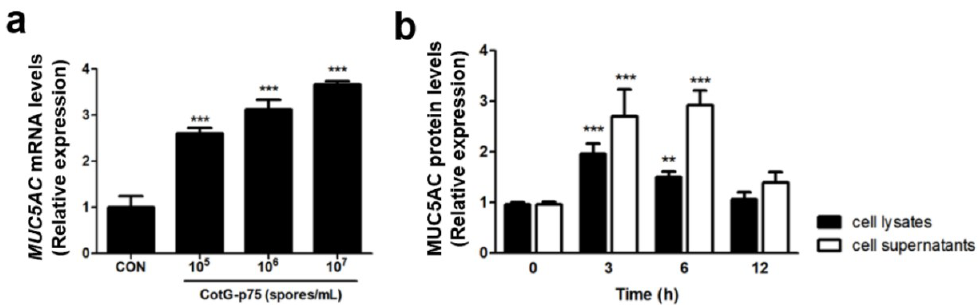
Figure 9. Effect of CotG-p75 on MUC5AC mRNA expression ( a ) and MUC5AC protein production ( b ). In panel ( a ), cells were treated with various concentrations of CotG-p75 (10 5 to 10 7 spores/mL) for 3 h. In panel ( b ), cells were treated with CotG-p75 (10 7 spores/mL) during various times (0, 3, 6, and 12 h). The mRNA expression levels and protein production levels in treated groups were compared with the control group. All data are expressed as mean ± standard deviation ( n = 3). Asterisks (*) indicate a significance difference from the control (** p < 0.01, *** p < 0.001).